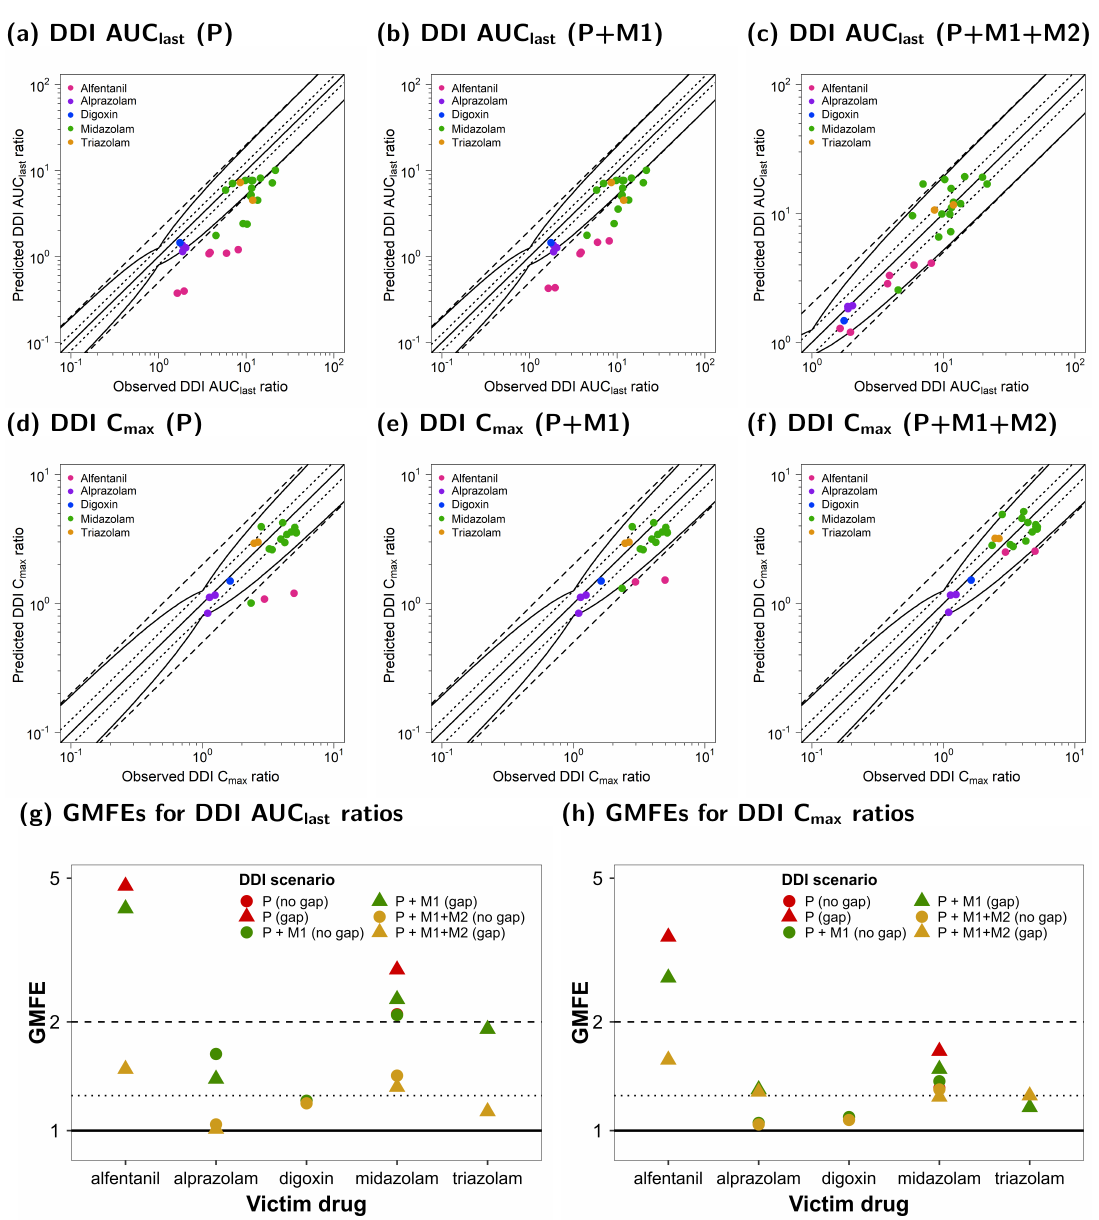
Figure 7. Ketoconazole DDI model evaluation. Predicted DDI AUC last ratios of DDI simulations of three scenarios (P ( a ), P + M1 ( b ), and P + M1 + M2 ( c )), as well as DDI C max ratios of three scenarios (P ( d ), P + M1 ( e ), and P + M1 + M2 ( f )) were compared to the respective observed data. The straight solid line marks the line of identity, and the curved solid lines show the prediction acceptance limits proposed by Guest et al. (including 1.25-fold variability) [52]. Calculated mean GMFE values for DDI AUC last ( g ) and DDI C max ratios ( h ) for the three scenarios (P, P + M1, and P + M1 + M2) stratified according to victim with or without a dosing time gap between ketoconazole administration. Dotted lines indicate 1.25-fold and dashed lines indicate two-fold deviation. Detailed information on the study protocols is provided in Table S3.7 in the Supplementary Materials. AUC last : area under the plasma concentration-time curve calculated from the first to the last concentration measurement; C max : maximum plasma concentration; DDI: drug–drug interaction; GMFE: geometric mean fold error; KTZ: ketoconazole; M1: N -deacetylketoconazole; M2: N -hydroxy- N -deacetylketoconazole; P: ketoconazole